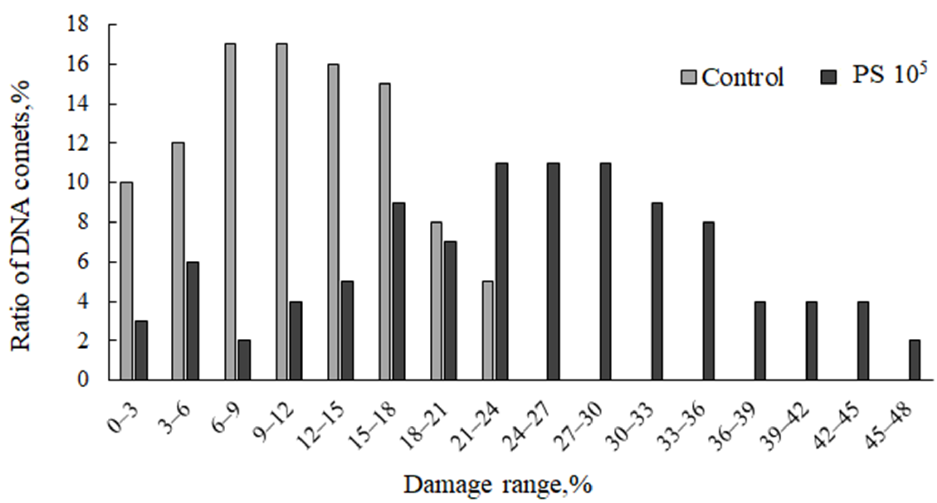
Figure 4. Distribution of DNA comet at 3% damage interval in sperm (N = 16; n = 800). In controls, the highest number of cells had a 6–18% damage range, with only 5% of cells showing the highest DNA content in the comet tail (21–24%). Upon short-term exposure to polystyrene microspheres, about one-third of the total number of spermatozoa had DNA damage in the range of 21–33%. In addition, about 10% of the cells